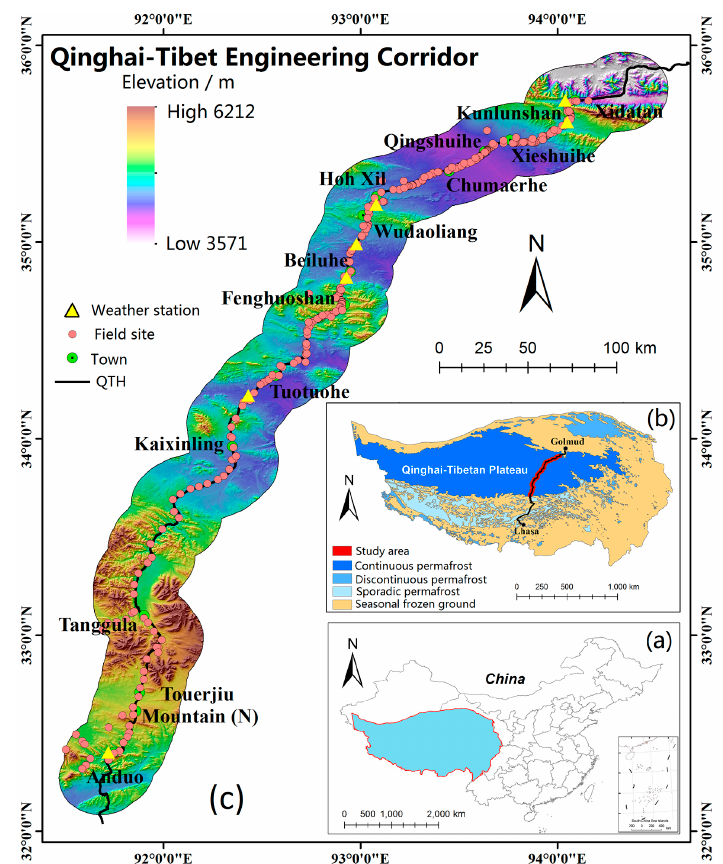
Figure 1. Study area map. ( a ) The Qinghai-Tibetan Plateau location in China; ( b ) map of Permafrost on the Qinghai-Tibetan Plateau (Modified based on the permafrost map by Li and Cheng [41]; ( c ) topographic map of the whole study area based on a 30-m DEM data, including mainly local geographic names of mountains and upland basins.